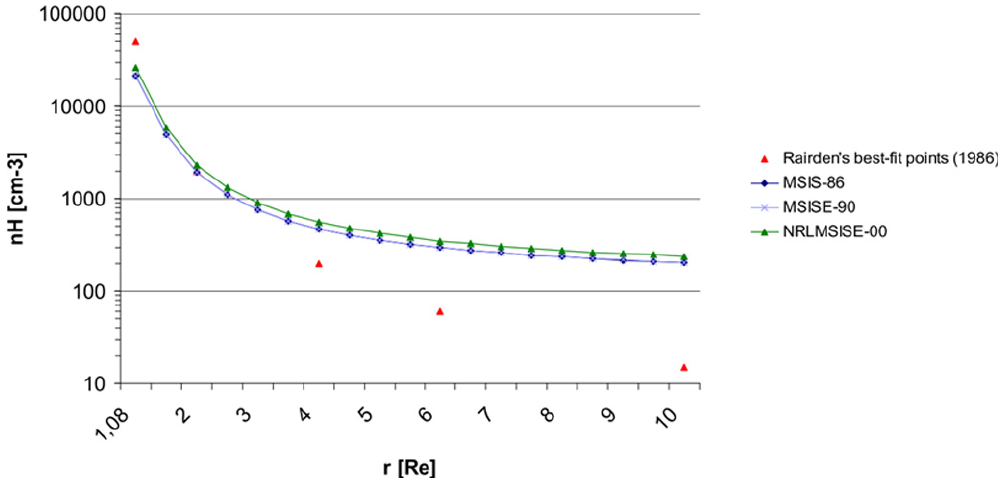
Fig. 6. Exospheric hydrogen density versus radial distance with extrapolated MSIS models.